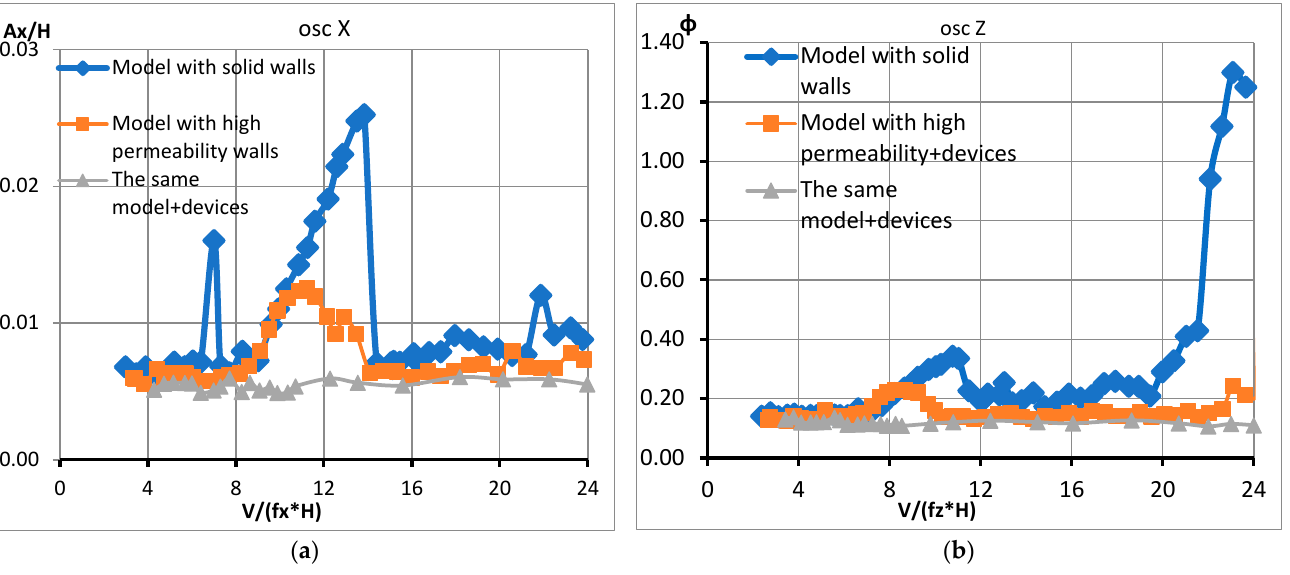
Figure 14. The comparative efficiency of decrease intensity of aeroelastic vibrations of the models with different types of walls and with or without devices in the horizontal plane ( a ) and torsional ( b ).